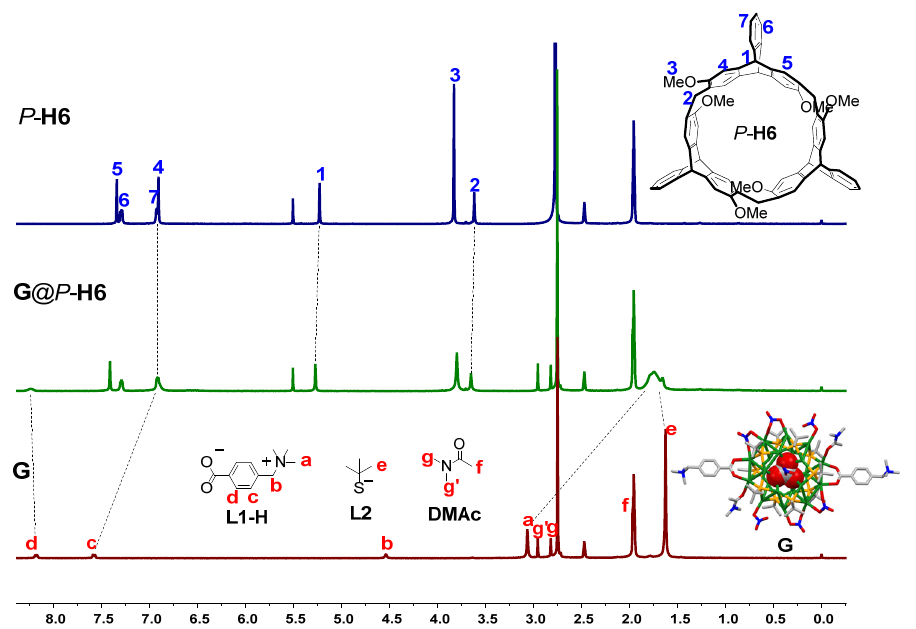
Figure 3. 1 H NMR spectra of P - H6 , G , and G @ P - H6 in CD 3 CN:DMSO- d 6 = 5:1 ( v / v ) at 298 K (400 MHz, P - H6 = 2.5 mM, G = 1.25 mM; blue and red symbols represent the proton signals of P - H6 and G , respectively).